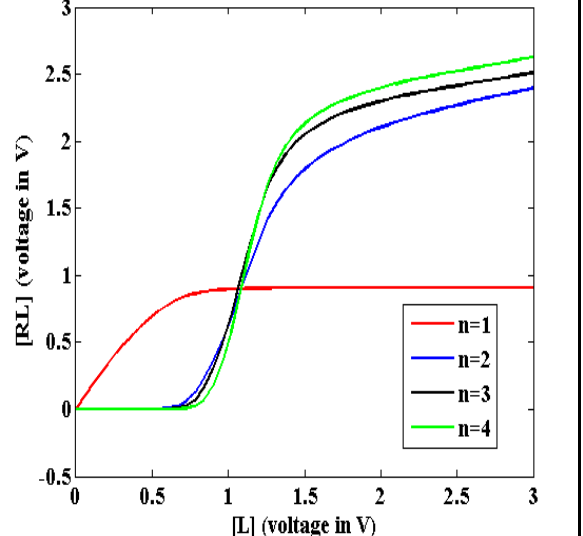
Fig. 7: Cadence simulation results for Hill Equation obtained from Electronic Circuit shown In Fig. 3, illustrating the effect of changing Hill Coefficient